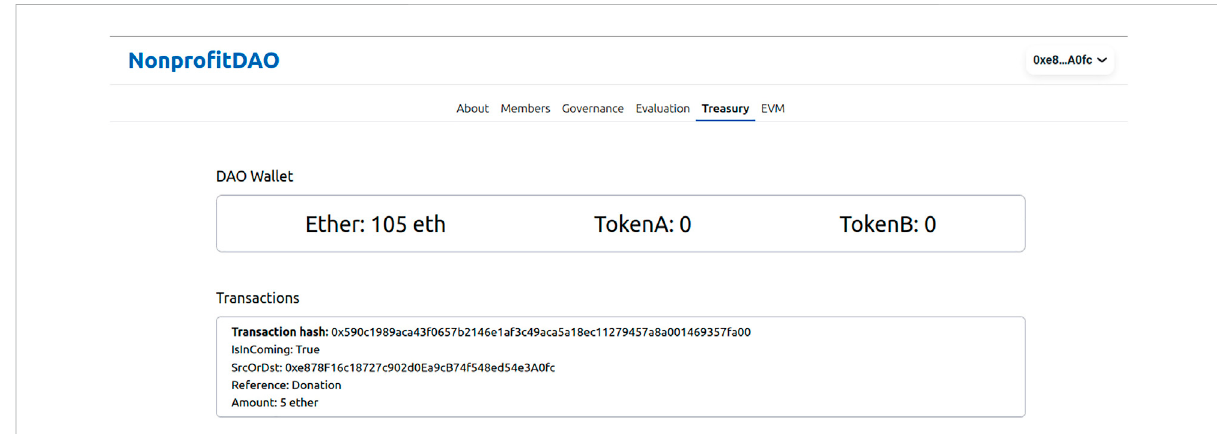
FIGURE 10 The fi nancesectioninthefront-endsoftware.Since100ETHwasalreadypre-depositedatthetimeofcontractcreationand5ETHwasdonated from Account6, the organization now has 105